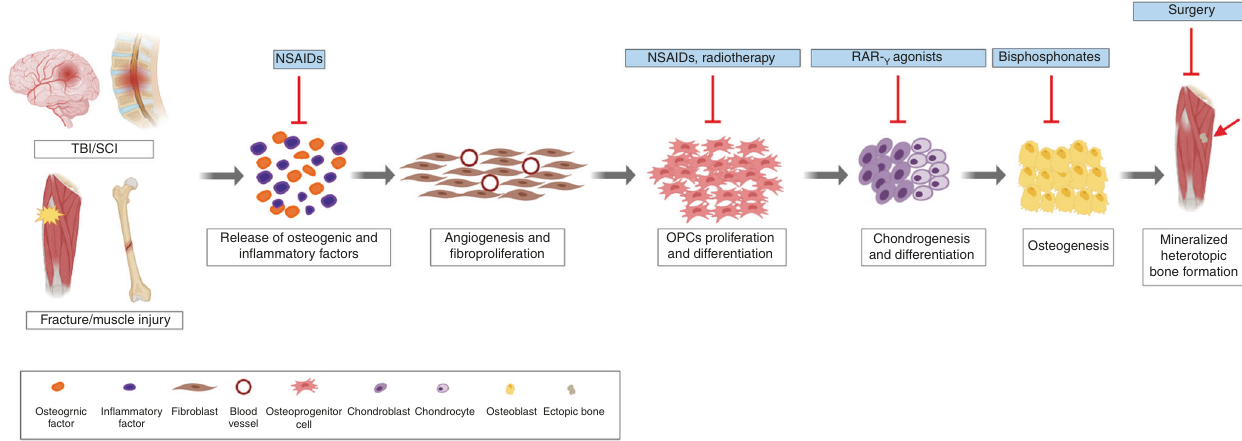
Fig. 2 Current treatments targeting speci fi c pathways of NHO. NHO development is triggered by a cascade of in fl ammatory factors. Presently, the preferred prophylactic treatment for NHO/HO involves NSAIDs (e.g. Indomethacin) to downregulate the in fl ammatory response and prevent OPC differentiation. Radiotherapy is thought to prevent the formation and development of ectopic bone speci fi cally by inhibiting the differentiation of OPCs. RAR- γ agonists have been shown to prevent chondrogenesis and therefore subsequent mineralisation. While, nitrogen-containing bisphosphonates (e.g. sodium etidronate) have been used to inhibit mineralisation, and the formation of ectopic bone. Finally, when bone is completely mineralised, surgical resection is the only remaining intervention. This invasive procedure, however, is accompanied by the risk of recurrence and is associated with complications which include incomplete resection, functional and physiological impairment (created with